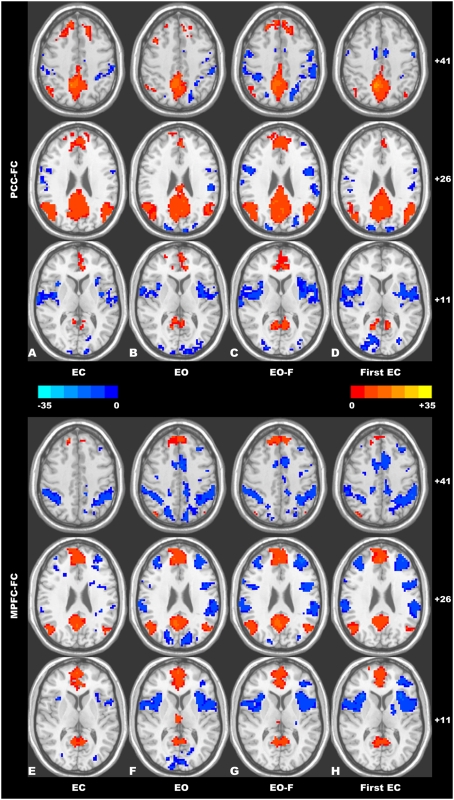
Within-condition functional connectivity patterns of the resting-state conditions: (A–D) the PCC-FC patterns for the EC, EO, EO-F, and the first EC conditions, respectively; (E–G) the MPFC-FC patterns for the EC, EO, EO-F, and the first EC conditions, respectively.The patterns of the DMN as well as its anti-correlated network were visually similar across the resting-state conditions. The numbers at the right side of the images refer to the z coordinates in the Talairach and Tournoux atlas. The statistical threshold was set at |t|>4.897 (P<0.0001) and cluster size >135 mm3, which corresponds to a corrected P<0.0001.